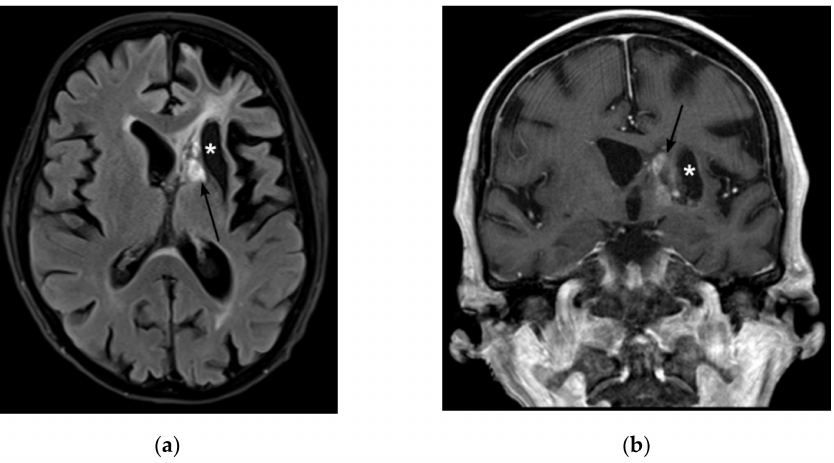
Figure 4. Magnetic Resonance Imaging (MRI) on day 251 after initial admission to the hospital ( a ) Fluid attenuated inversion recovery (FLAIR) shows regressing lesions with mixed T2 signal (arrow) and a hypointense tissue defect at the former site of the abscesses (star). ( b ) Contrast- enhanced T1-weighted image in corona shows regressive enhancement of the